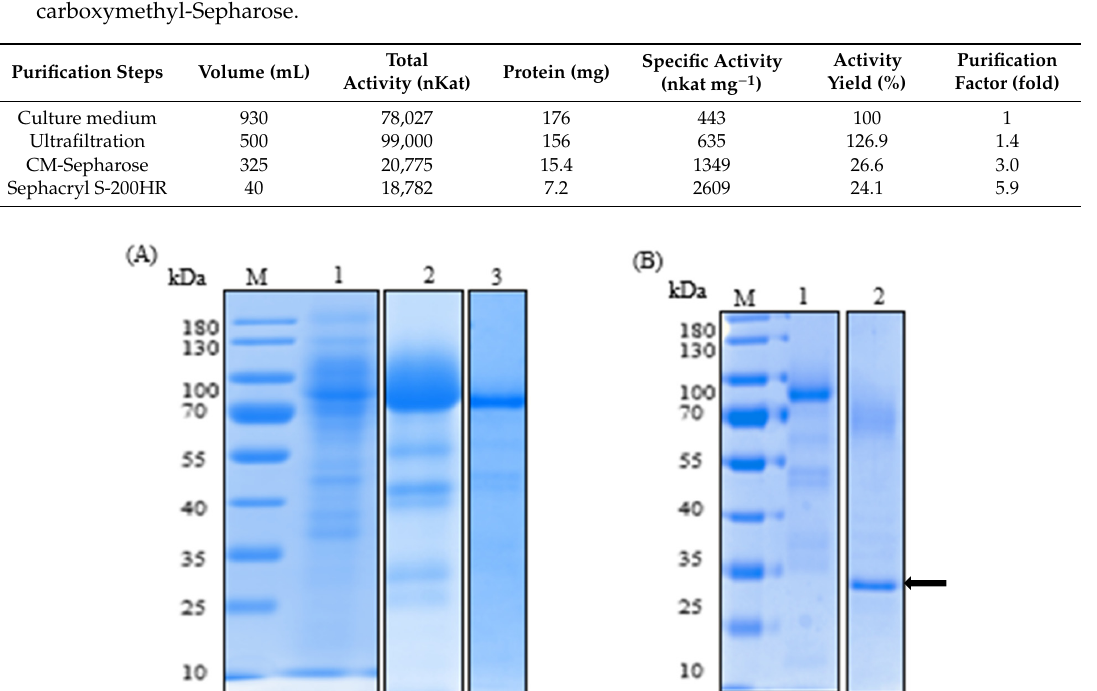
Table 2. Purification for the recombinant Sl Lac2 produced in Aspergillus niger D15#26. CM-Sepharose: